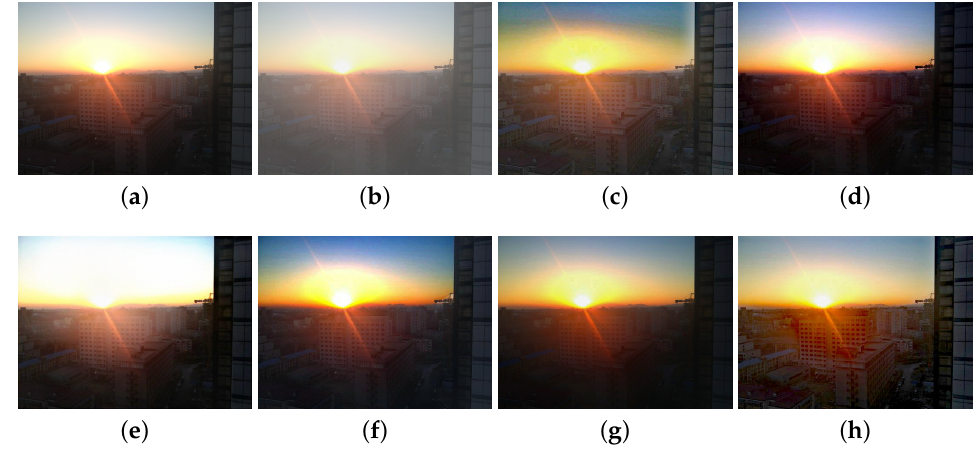
Figure 8. Sunlight of the SOTS-outdoor dataset.( a ) Ground truth image. ( b ) input blur image. ( c ) DCP; ( d ) Berman; ( e ) DCPDN; ( f ) Zhu; ( g ) Golts; ( h )